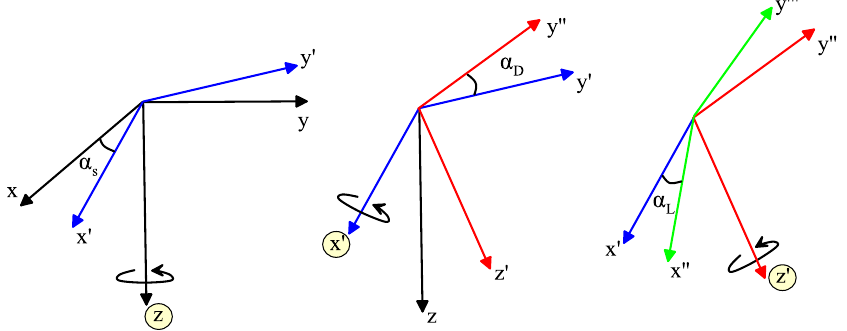
Figure 1. Rotation matrix of anisotropic resistivity tensor.